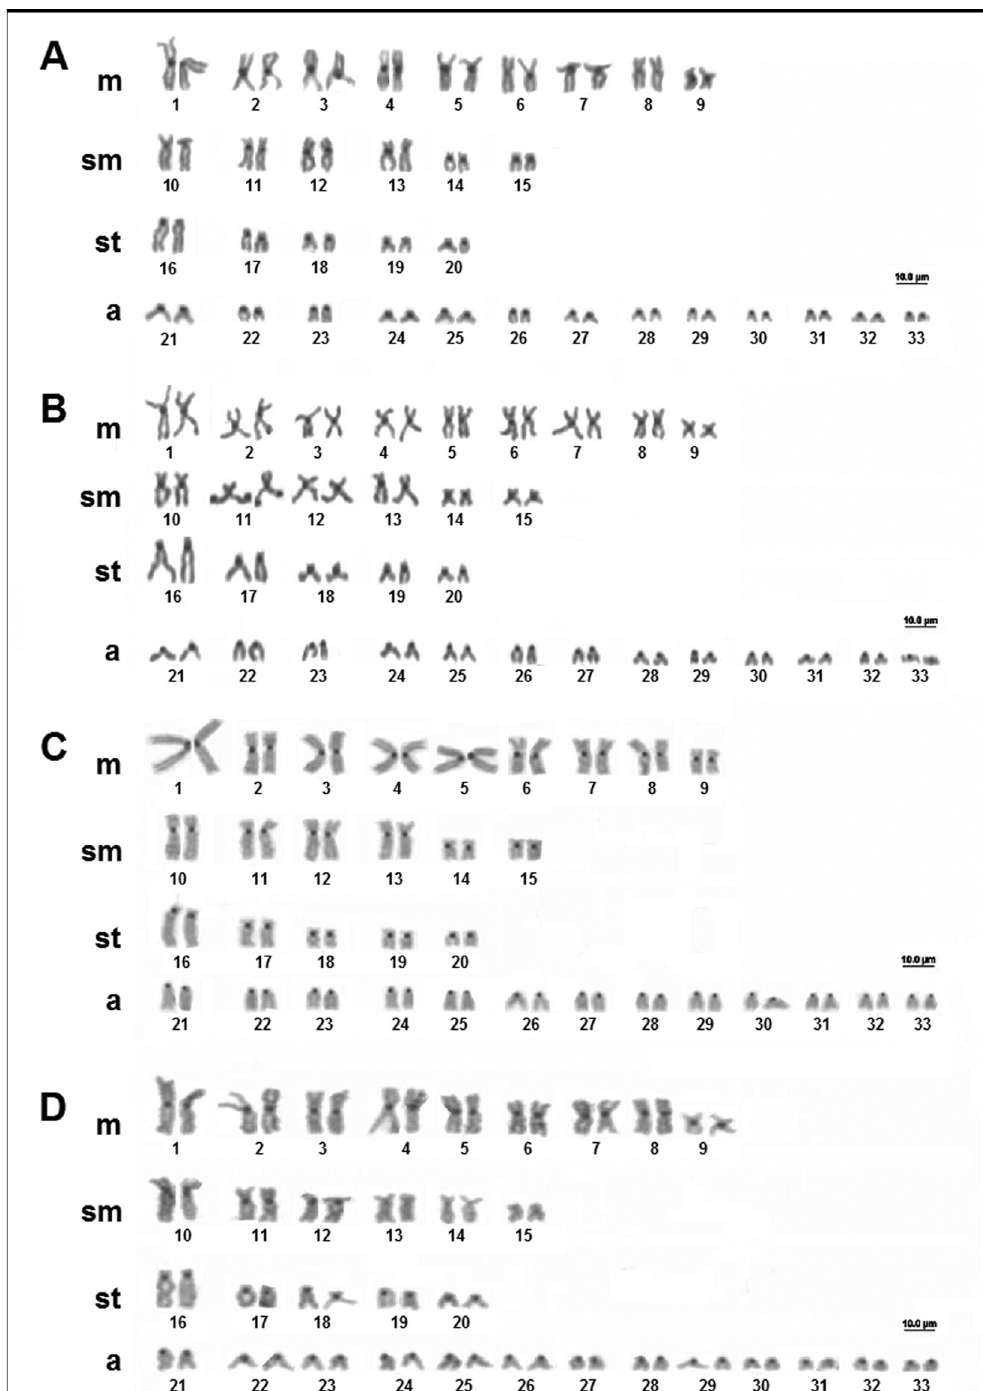
Figure 6 - Karyotypes of Potamotrygon motoro : C-banding of individuals from different localities: (A) middle Negro River, Barcelos region; (B) Jauaperi River, middle Negro basin; (C) Catalão Lake, lower Negro basin; (D) Janauacá Lake, Solimões